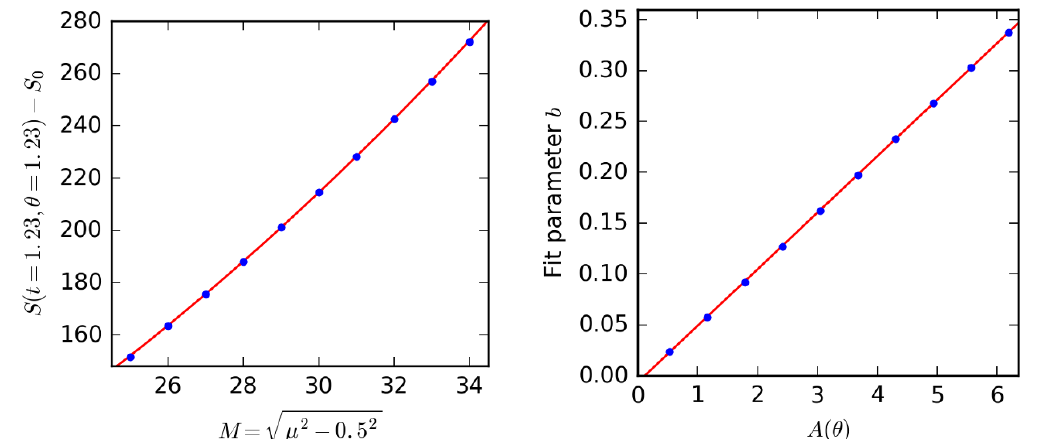
Figure 6 . Mass dependence of entanglement entropy at saturation time (with the t = 0 value subtracted). The left graph is for a polar cap of size (cid:18) = 1 : 23 rad. The solid line is a quadratic (cid:12)t with coe(cid:14)cient b = 0 : 227 (and a constant term). The graph on the right shows the value of the (cid:12)t parameter b for polar caps of various areas (with masses taken in the same range). The slope of the (cid:12)t line is